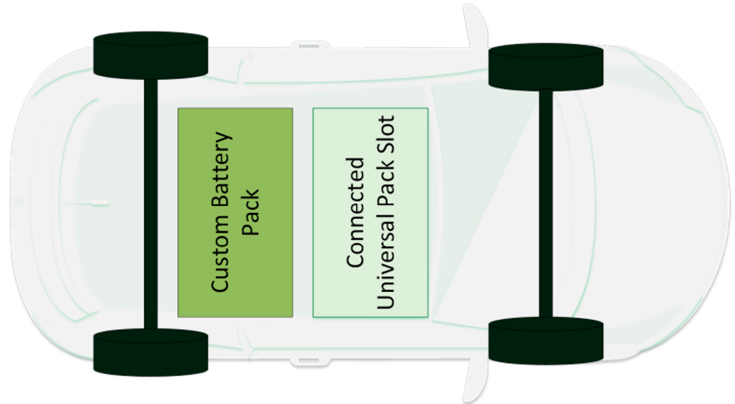
Figure 10. EV with modular pack and slot for the universal battery pack (UBP).